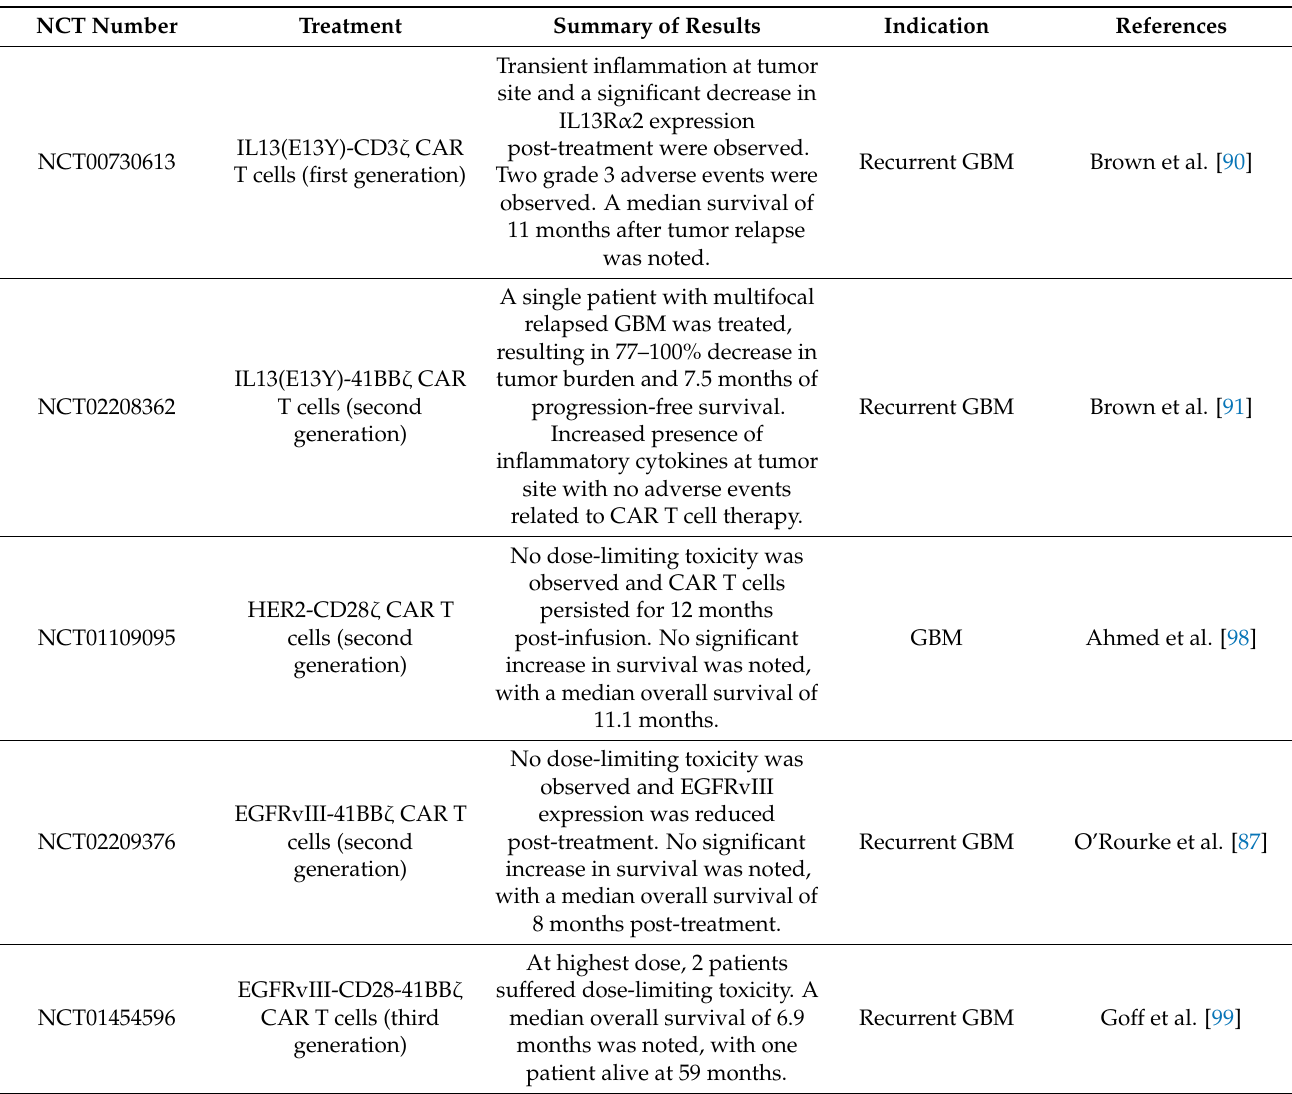
Table 3. Summary of clinical trials for CAR T cells against